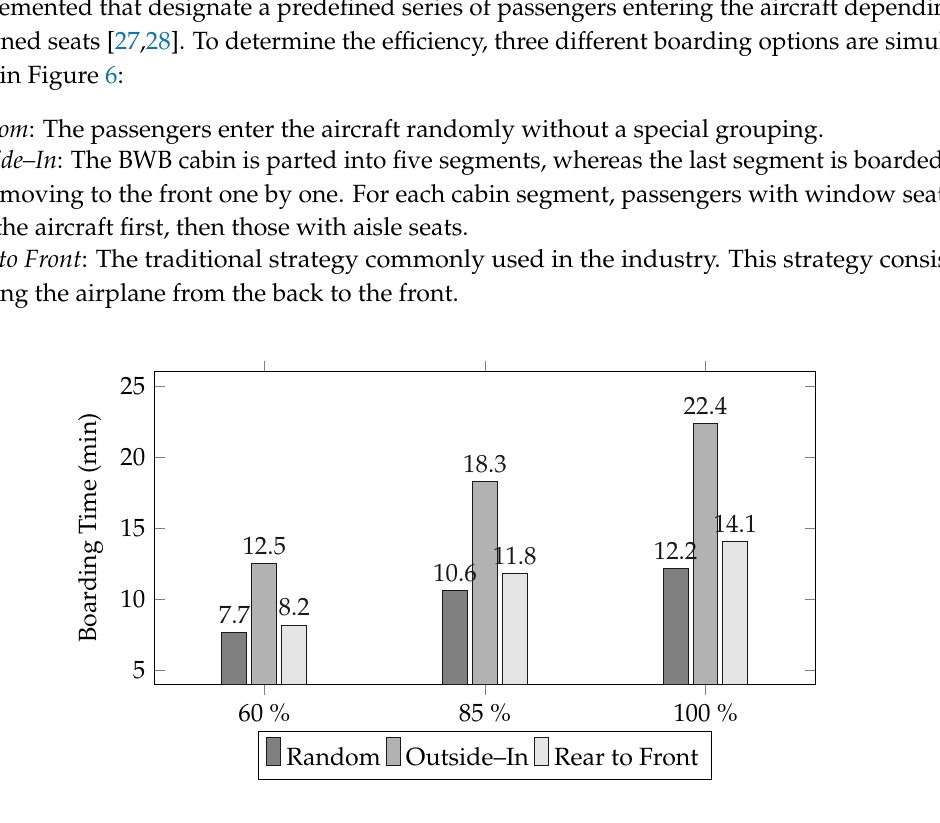
Figure 6. Efficiency of different boarding strategies for the blended wing body (BWB) with two front